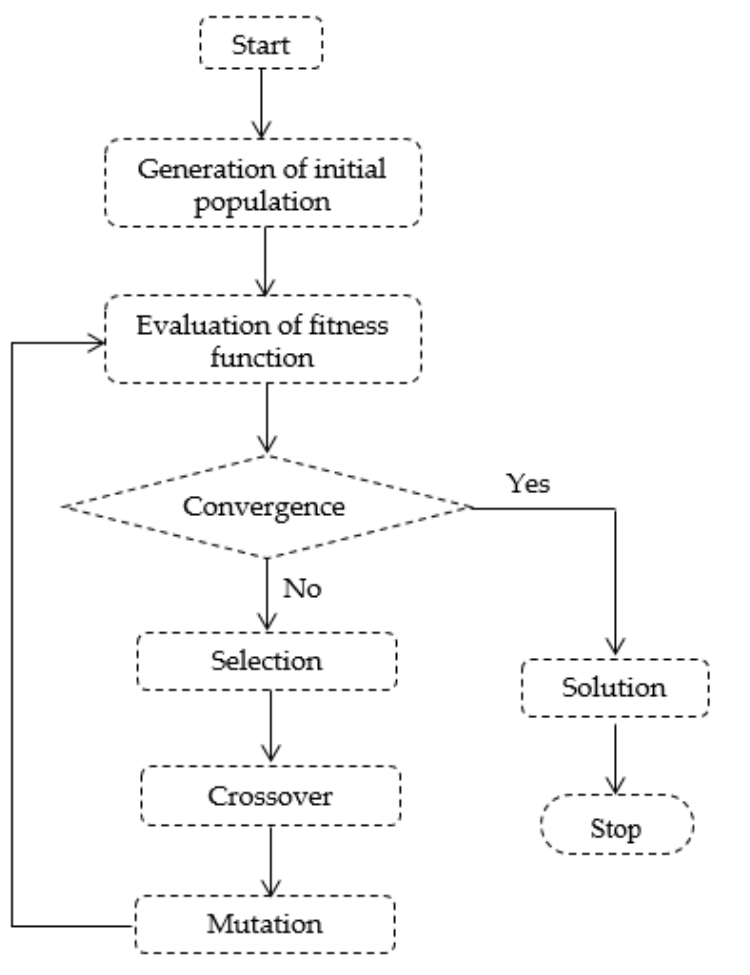
Figure 11. Flowchart of genetic algorithm.